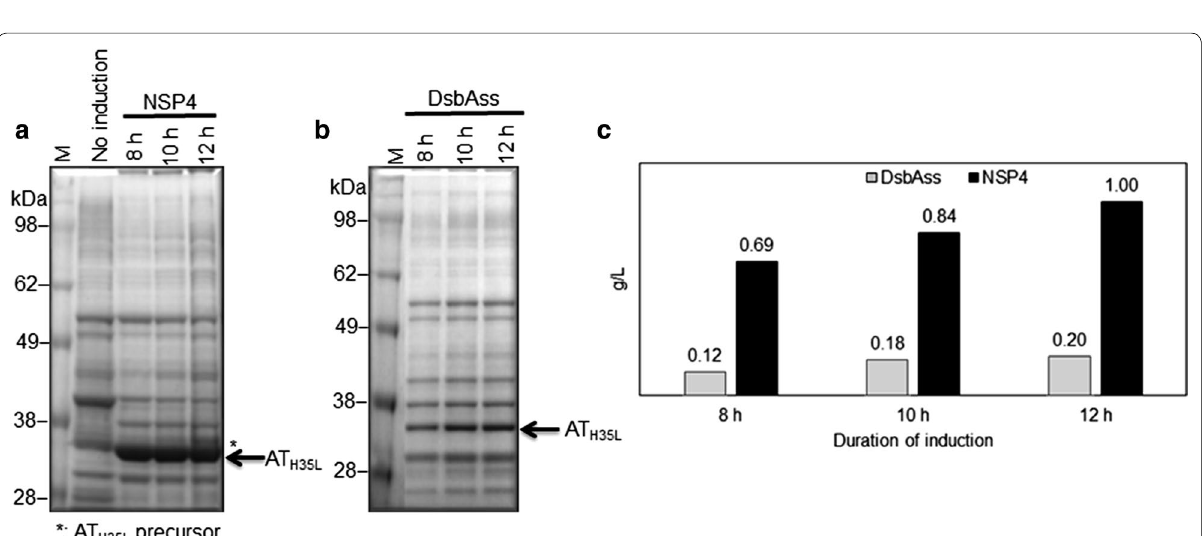
Fig. 6 Optimization of induction time for extracellular AT H35L production. Cell culture medium samples were collected every 2 h from 8 h post- induction. SDS-PAGE analysis of extracellular AT H35L production by NSP4 ( a ) and by dsbAss ( b ); c Comparison of extracellular AT H35L production between dsbAss and NSP4 at various induction